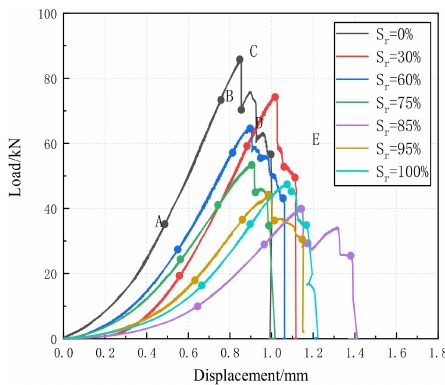
Figure 4. Load displacement curve of sandstone with different